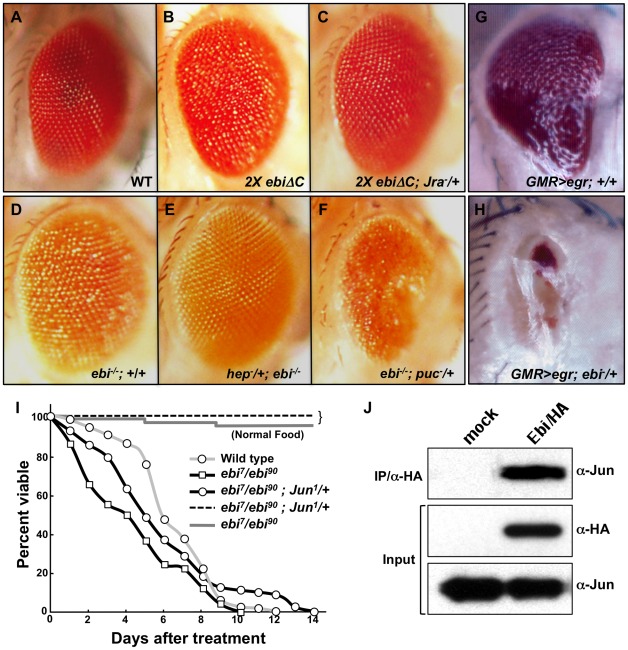

ebi interacts with Jra and antagonizes JNK signaling.Compound eyes from wild type (A), GMR-ebiΔC, GMR-ebiΔC/+ (2×ebiΔC) (B), GMR-ebiΔC, GMR-ebiΔC/Jra1 (2×ebiΔC; Jra1/+) (C), ey-FLP; ebiP, FRT40A/CycEAR95, FRT40A (ebi
−/−) (the same genotype as in Figure 1C–E) (D), hepr75/ey-FLP; ebiP, FRT40A/CycEAR95, FRT40A (hepr75/+; ebi
−/−) (E), and ey-FLP; ebiP, FRT40A/CycEAR95, FRT40A; pucE68/+(ebi
−/−; pucE68/+) (F). (G, H) ebi showed a strong genetic interaction with TNF-α. (G) GMR-Gal4/+; egrGS11687/+, TNF-α overexpression induced a small-eye phenotype (Igaki et al. 2002). (H) GMR-Gal4/+; egrGS11687/ebi4, in which a copy of ebi was removed, enhanced the eye phenotype. (I) Lifespan analysis for wild type and for strains containing ebi mutants (ebi7/ebi90) and ebi mutants with a copy of Jun removed (ebi7, Jra1/ebi90, +) cultured with or without 7.5 mM paraquat. Wild-type flies died within 12 days (open circle and gray line). Strong enhancement occurred in ebi mutant escapers (open square and black line). Removing a copy of Jun suppressed the sensitivity to paraquat (open circle and black line). The median life span was 5.9 d, 4.2 d, and 5.1 d for wild-type, ebi mutant, and ebi mutant with Jun males, respectively. Statistical analysis was performed using the log rank test. For wild type versus ebi mutant, p<0.001. For ebi mutant versus ebi mutant with a copy of Jun removed, p<0.001. n = 100. (J) Immunoprecipitation assay. S2 cells were transfected with a HA-ebi expression vector, and proteins were immunoprecipitated with hemagglutinin antibody and immunoblotted as indicated.